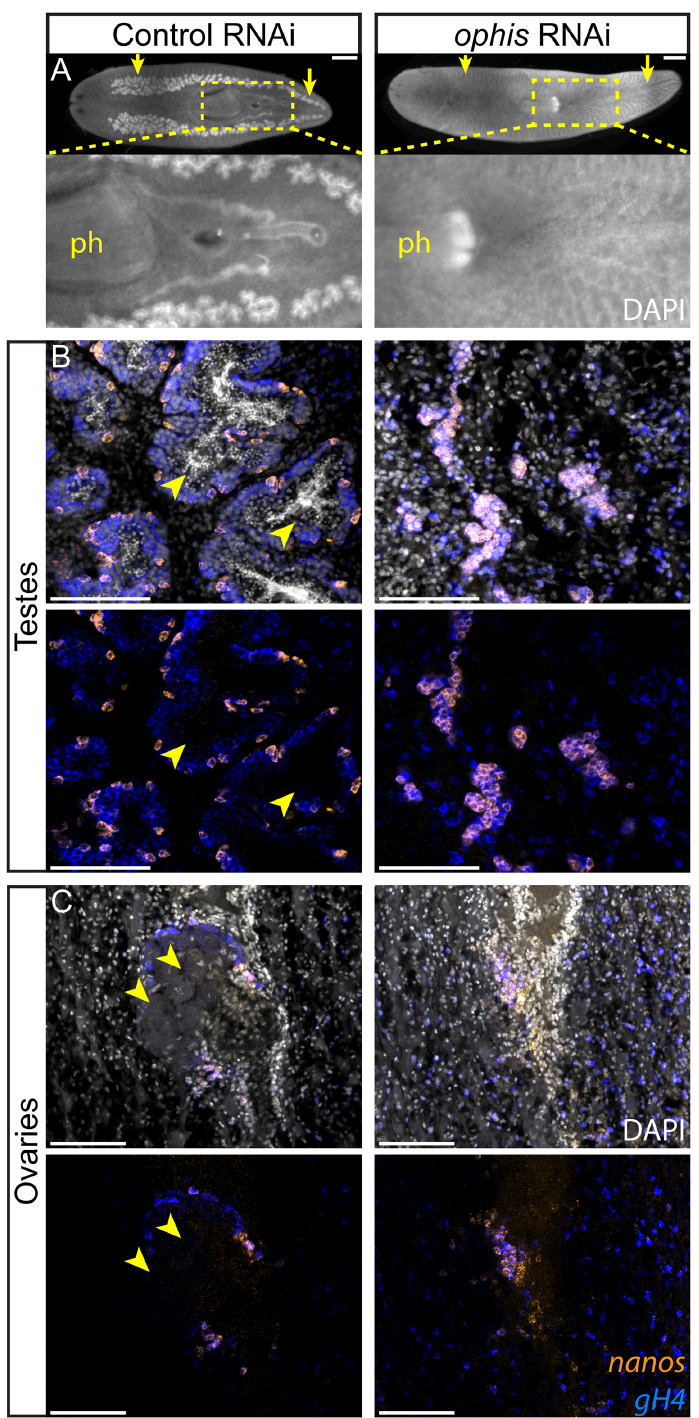
Fig 5. ophis is required for male and female germ cell differentiation. (A) Whole-mount DAPI staining of control and ophis(RNAi) worms shows testes (yellow arrows) and stored sperm (inset). Control animals ( n = 5/5) possess a mature reproductive system, including all differentiated cell types of the testes and ovaries, ophis(RNAi) worms ( n = 15/15, three independent experiments) lack gonads and mature gametes. RNAi treatment (8 dsRNA feedings) started in hatchlings (see Fig 2A for the dsRNA feeding paradigm). RNAi quantification data can be found in S4 Data. (B and C) Double-FISH labeling GSCs ( nanos + , orange)